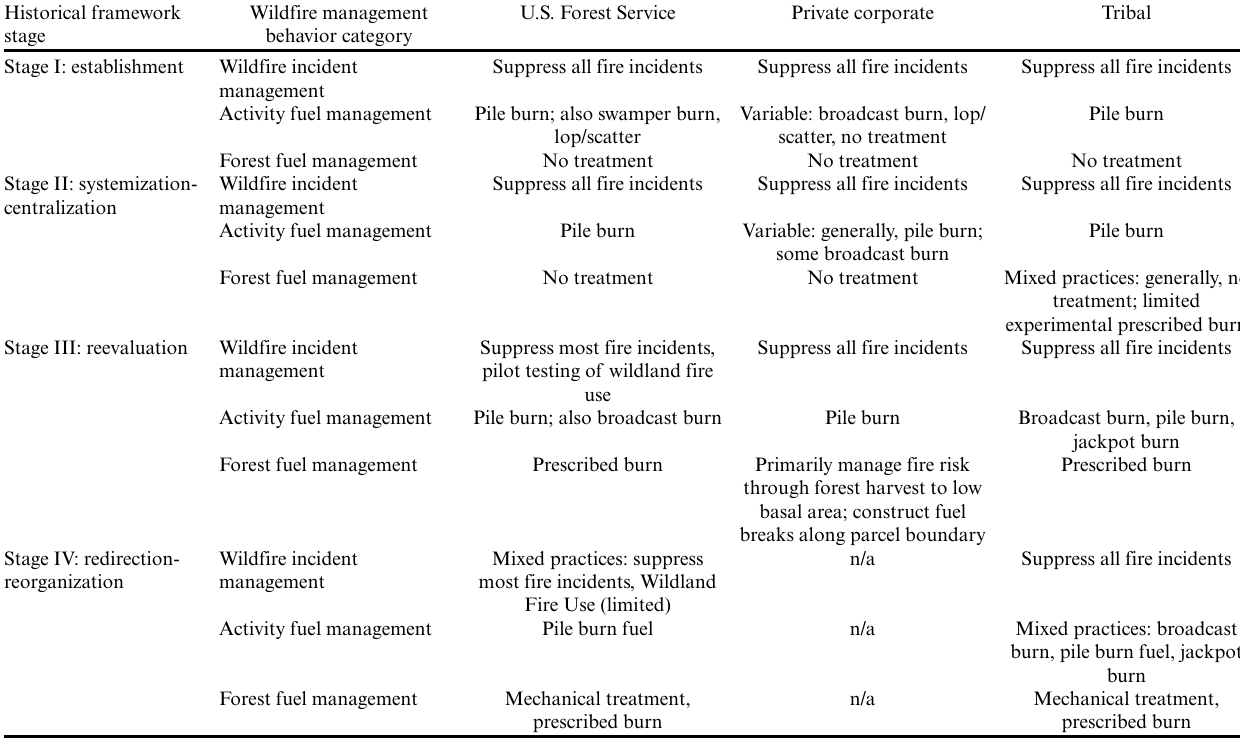
Table 3. Evolution of wildfire management behavior among U.S. Forest Service, private corporate, and tribal landowner groups. Historical framework